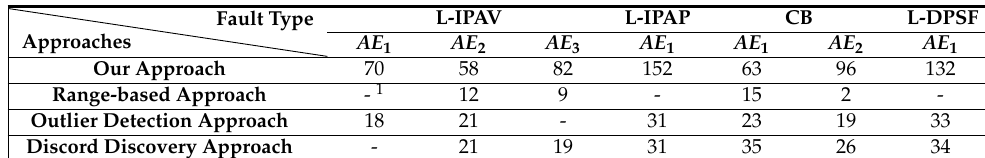
Table 3. Warning time of different approaches (unit: